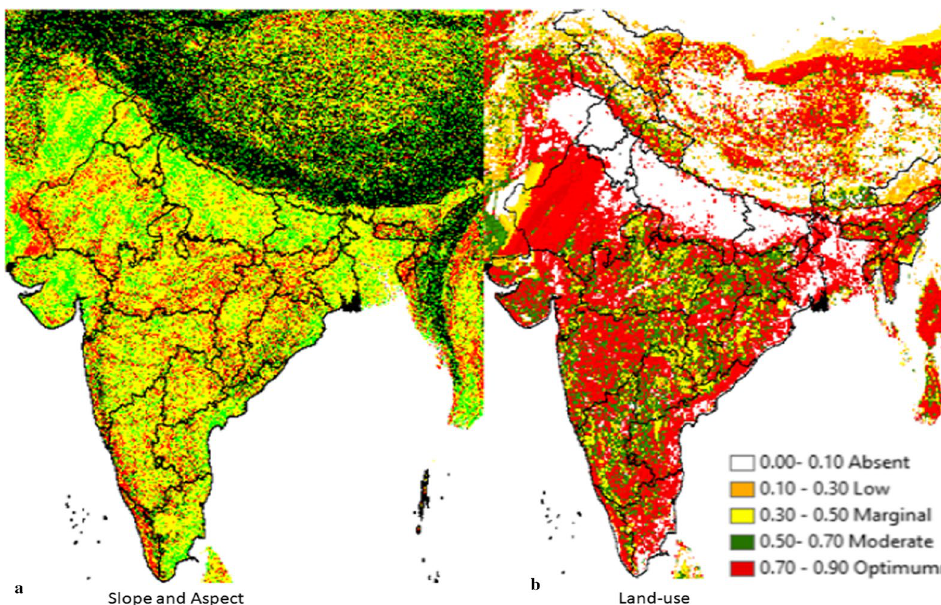
Fig. 16 Projected habitat suitability classes of C. wightii in India with non-bioclimatic variables slope ( a ) and land use ( b )